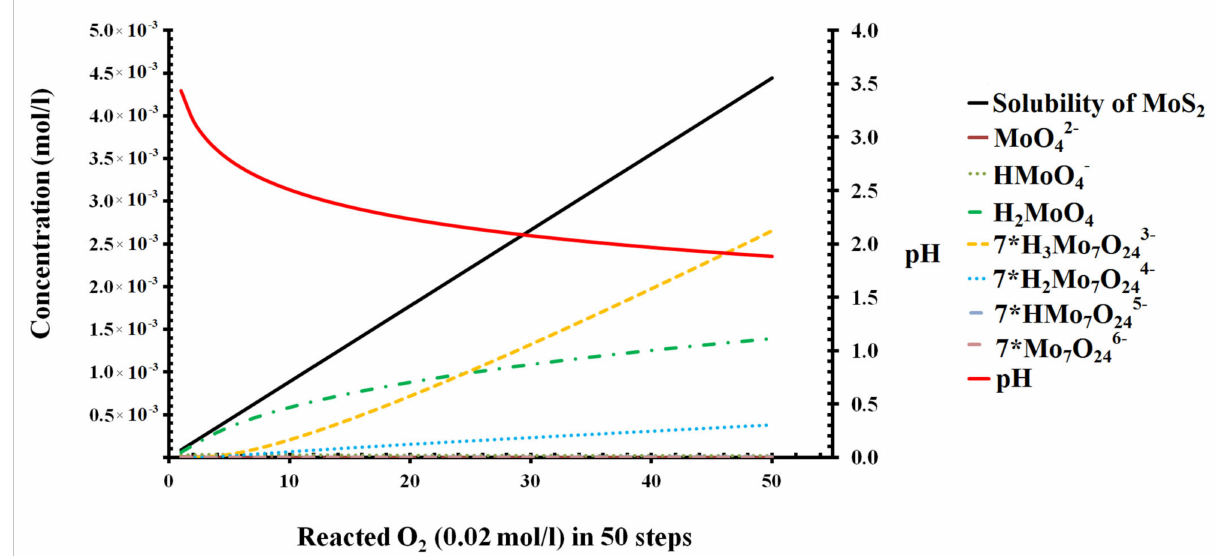
Figure 3. Oxidation process of molybdenite and speciation change as a function of the number of reaction